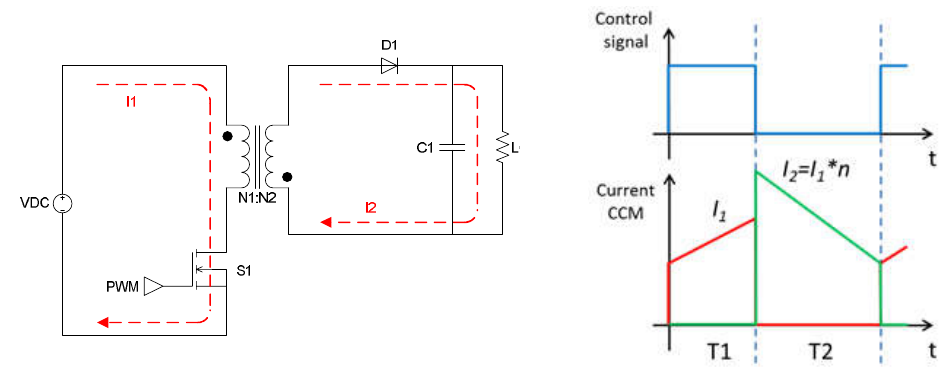
Figure 12. Currents through the windings of flyback transformers, time domain.